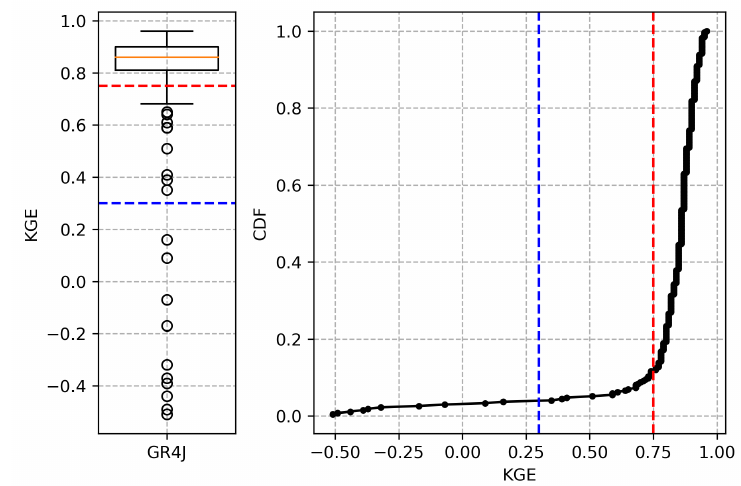
Figure 6. Basin-scale calibration results for the GR4J model. The box plot (left plot) and cumulative density function (CDF, right plot) demonstrate the distribution of calibration efficiency for all 275 R5 basins in terms of KGE. The boxplot box represents the Interquartile Range (IQR, the difference between the 25th and 75th quantiles); the whiskers represent ± 1.5 IQR from the 25th and 75th quantiles, respectively; the yellow line denotes the median value. The blue dashed line represents the threshold for behavioral predictions (KGE ≥ 0.3); the red dashed line—the threshold used for the selection of donor basins (KGE ≥ 0.75).